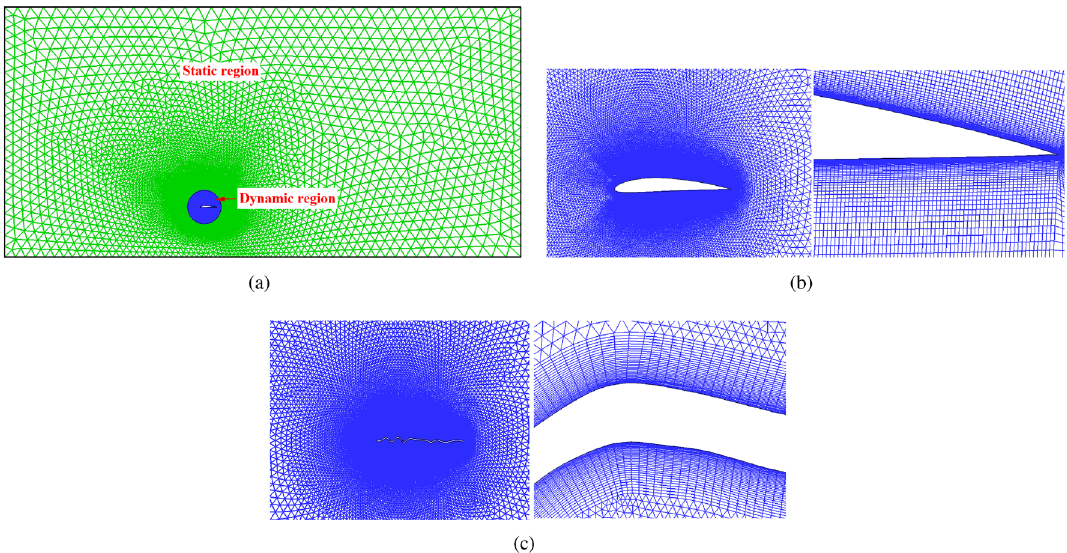
Figure 3. ( a ) Unstructured grids around airfoils ( b ) Close-up view of grid near NACA 4412 airfoil ( c ) Close-up view of grid near dragonfly airfoil.